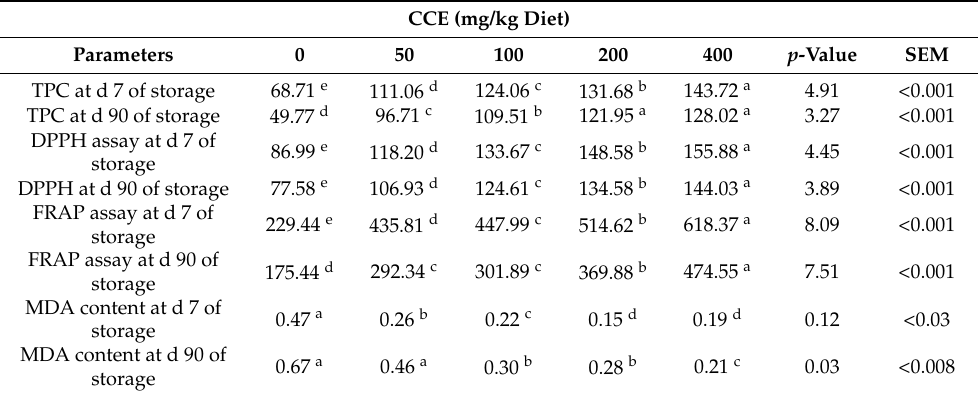
Table 7. Effect of different levels of cornelian cherry extract (CCE) on breast meat total phenolic content oxidative stability and lipid peroxidation during freezing storage at − 20 ◦